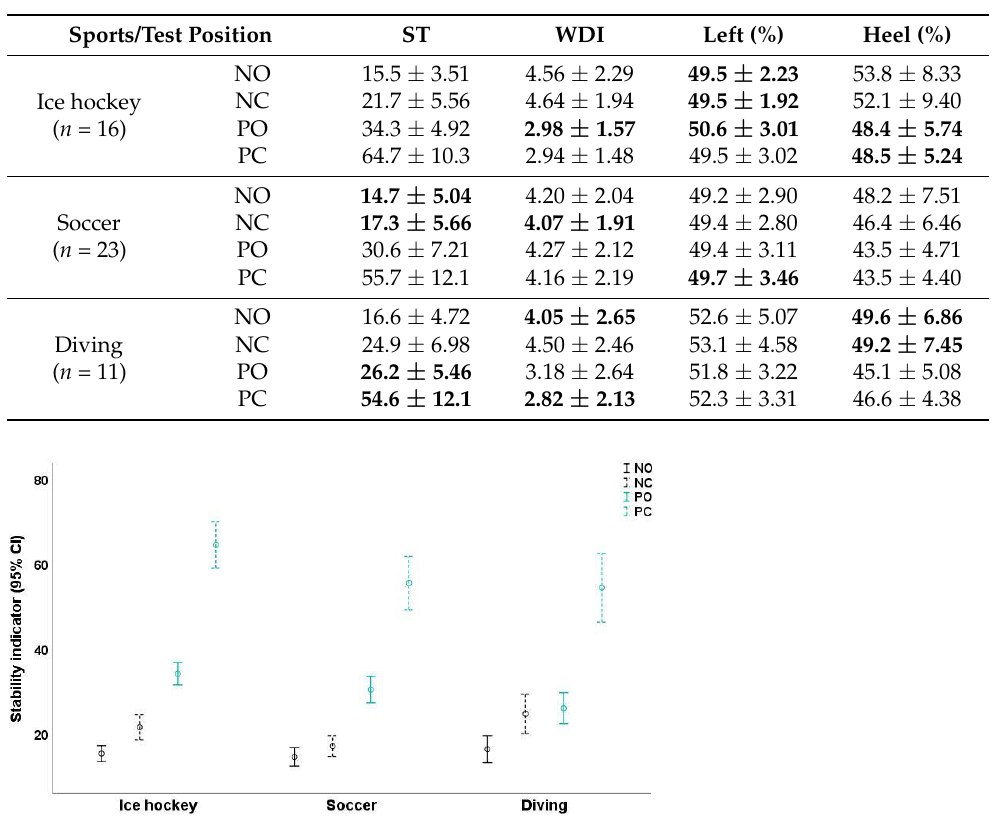
Table 2. Descriptive comparison (mean ± standard deviation (SD)) between sports depending on test positions. Performance maxima per position and parameter marked in bold.